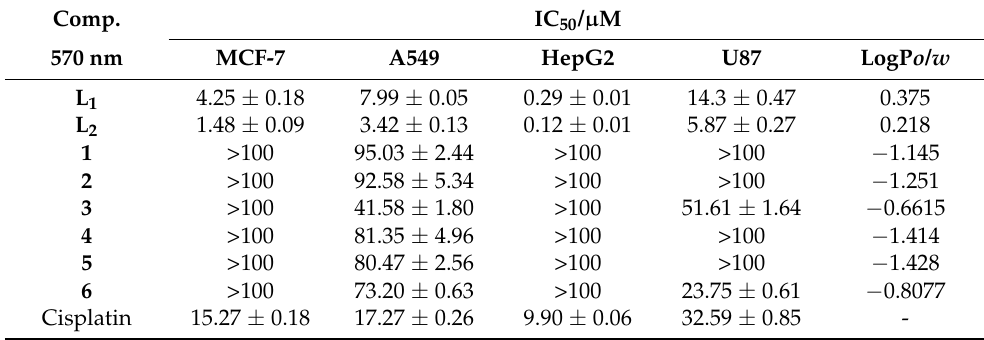
Table 2. Anticancer activities of complexes against human cancer cells after 72 h of incubation and the corresponding lipophilicity (mean value of three experiments). Comp. IC 50 / µ